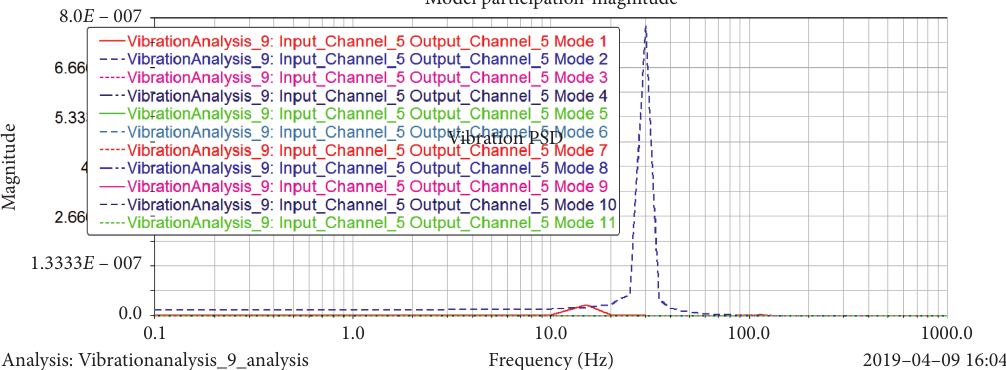
Figure 15: The modal participation factor